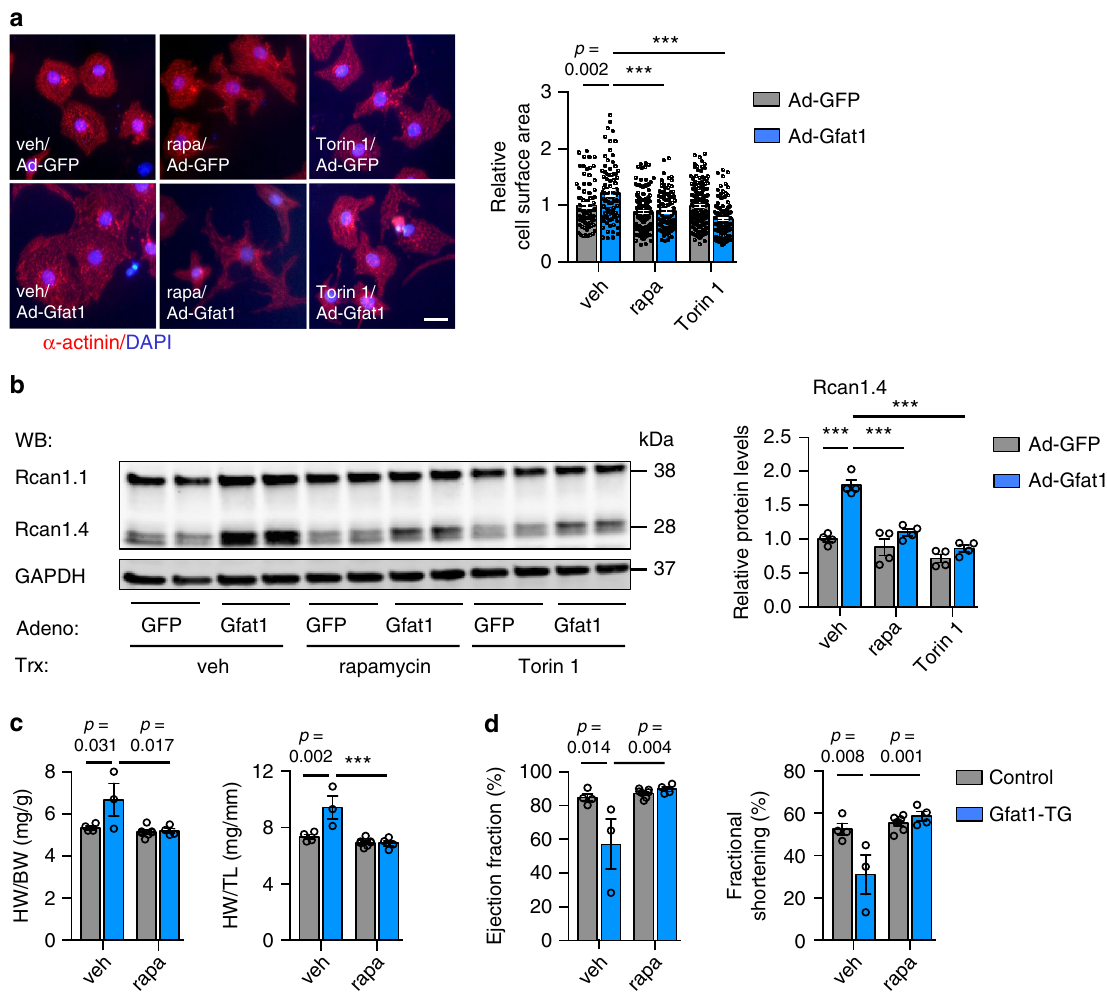
Fig. 9 Inhibition of mTOR suppresses Gfat1-induced hypertrophic growth. a Pharmacological inhibition of mTOR by rapamycin or Torin 1 prevented cardiomyocyte growth from Gfat1 overexpression. Adenovirus-mediated overexpression of Gfat1 led to an increase in cardiomyocyte size, which was suppressed by either rapamycin (20 nM) or Torin 1 (50 nM) treatment in NRVMs. Scale: 20 μ M. N = 80 cells for Ad-GFP/veh; n = 88 cells for Ad-Gfat1/ veh; n = 143 cells for Ad-GFP/rapa; n = 104 cells for Ad-Gfat1/rapa; n = 170 cells for Ad-GFP/Torin 1; n = 120 cells for Ad-Gfat1/Torin 1. At least three independent experiments were conducted with two to three samples/group/experiment. b Inhibition of mTOR caused a decrease in Rcan1.4 expression in NRVMs. Western blotting was conducted to evaluate the expression Rcan1. In contrast to Rcan1.4, Rcan1.1 expression remained unchanged. N = 4. c Rapamycin treatment in vivo inhibited the hypertrophic growth by Gfat1 overexpression, as assessed by the ratios of heart weight/body weight (HW/ BW) and heart weight/tibia length (HW/TL). Note that all mice underwent TAC surgery. N = 4 for control/veh; n = 3 for Gfat1-TG/veh; n = 7 for